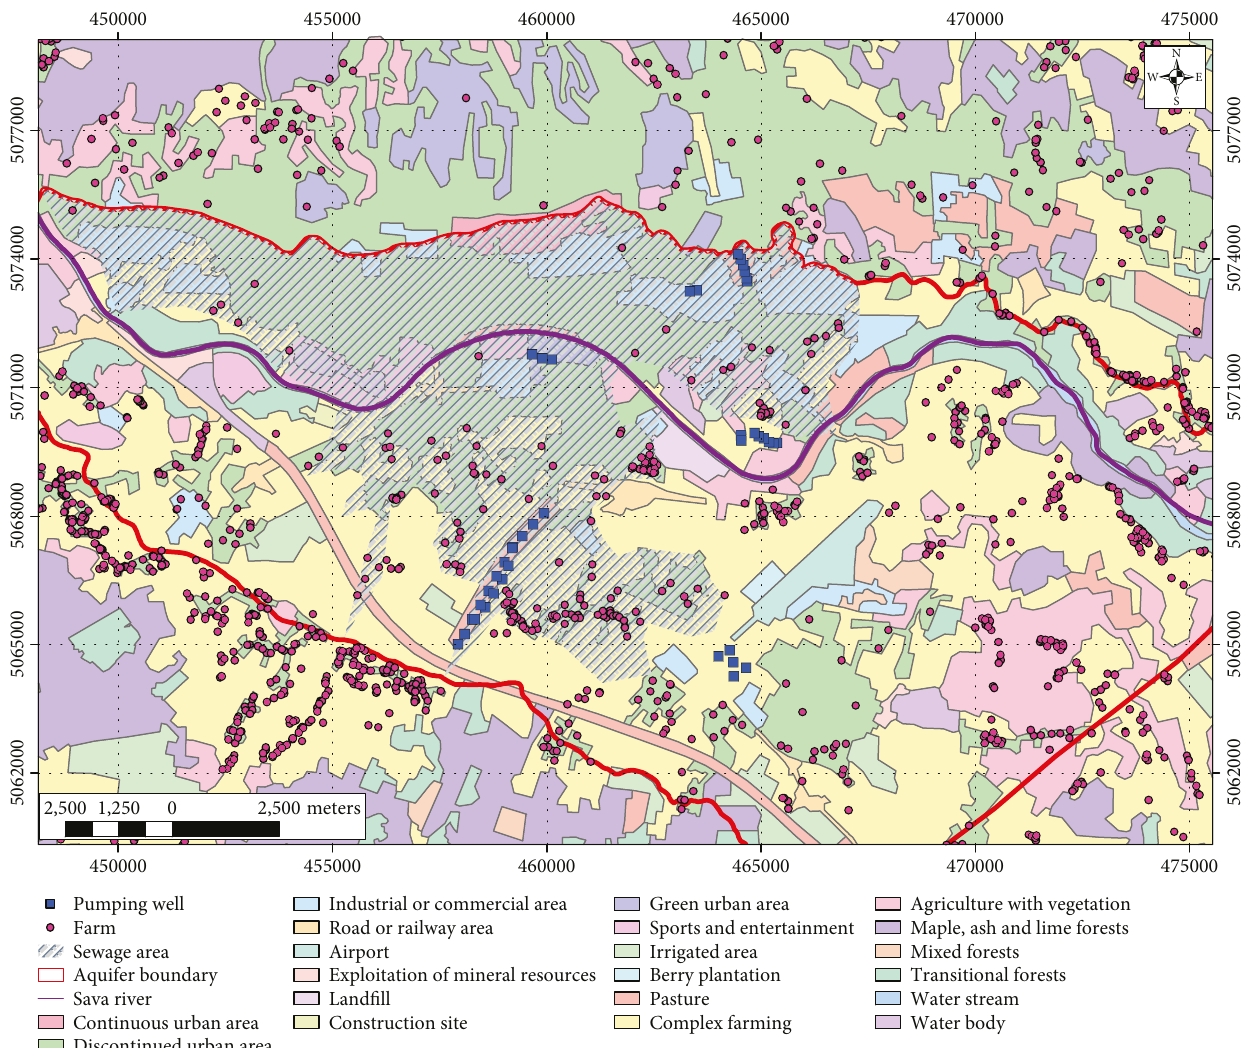
Figure 2: Potential contaminants in the area of the Zagreb aquifer